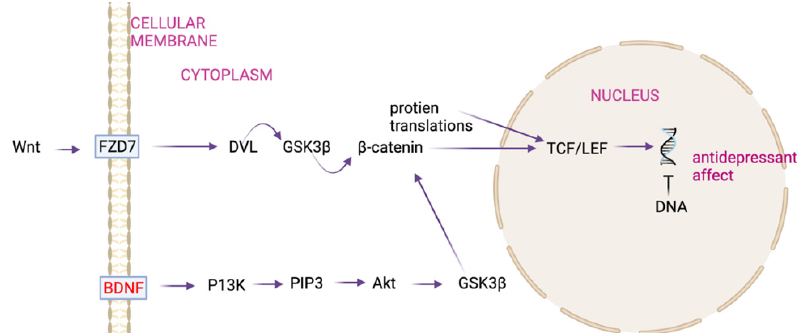
Figure 1. Diagram of the Wingless-related integration site as it functions in a person with Bipolar Disorder. The genes mentioned are Frizzled homolog 7 (FZD7), Glycogen Synthase Kinase 3 Beta (GSK3B), Beta Catenin (B-catenin), T-cell factor/lymphoid enhancer factor (TCF/LEF), Brain-Derived Neurotrophic Factor (BDNF), Phosphoinositide 3-kinases (P13K), phosphoinositide 3 kinase (PIP3), Protein kinase B (Akt). The diagram illustrates how, starting with the BDNF gene, the pathway functions, eventually leading to the antidepressant effect in people.